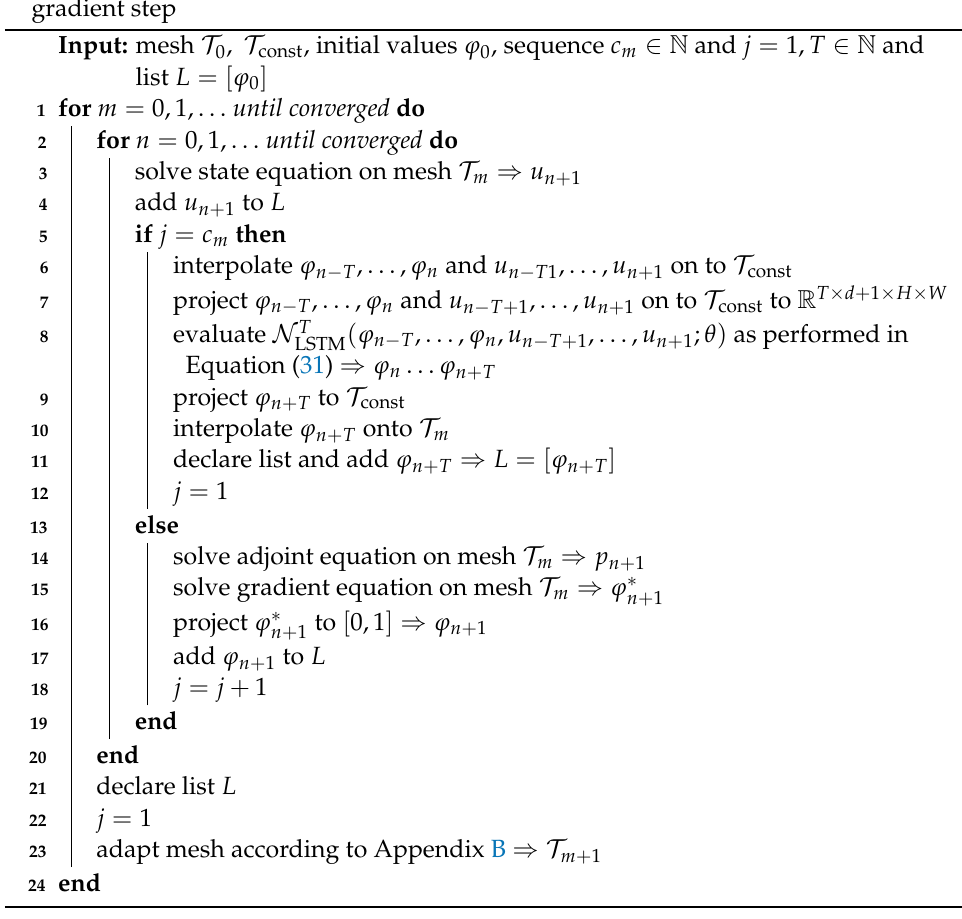
Algorithm 3: Deterministic optimisation algorithm with TLSTM